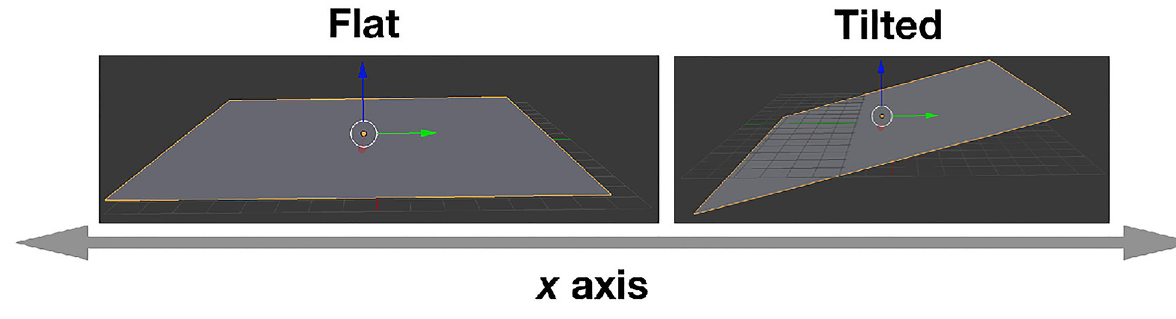
Fig 6. The Flat and Tilted